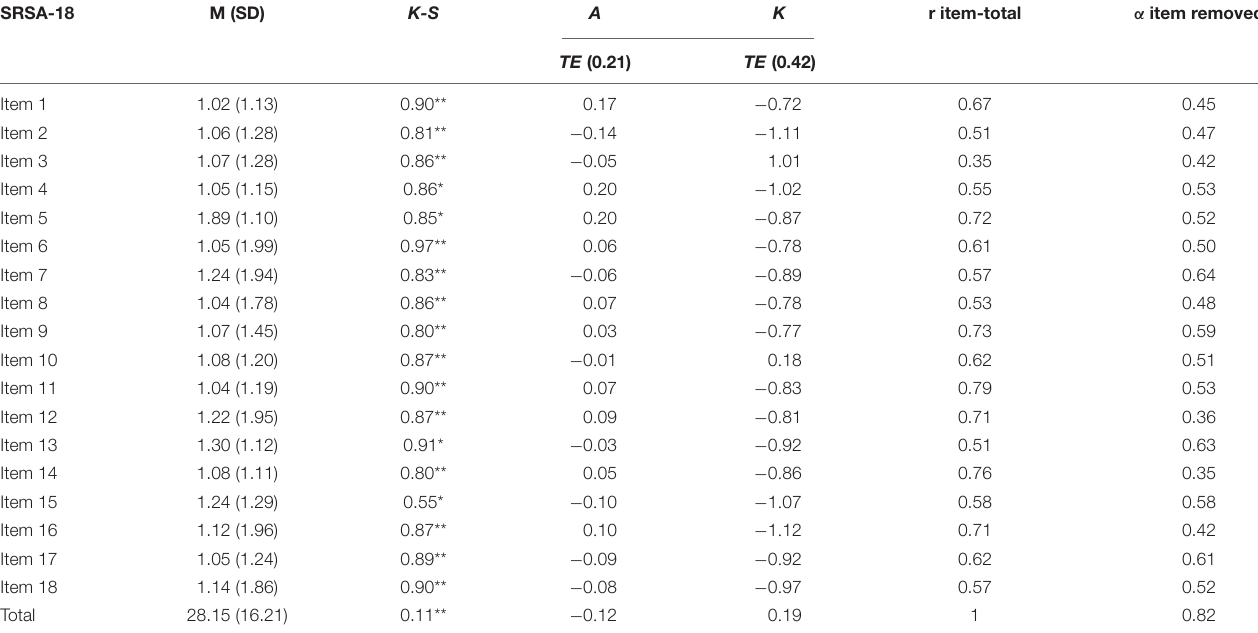
TABLE 2 | Descriptive statistics, asymmetry, kurtosis, and item analysis.